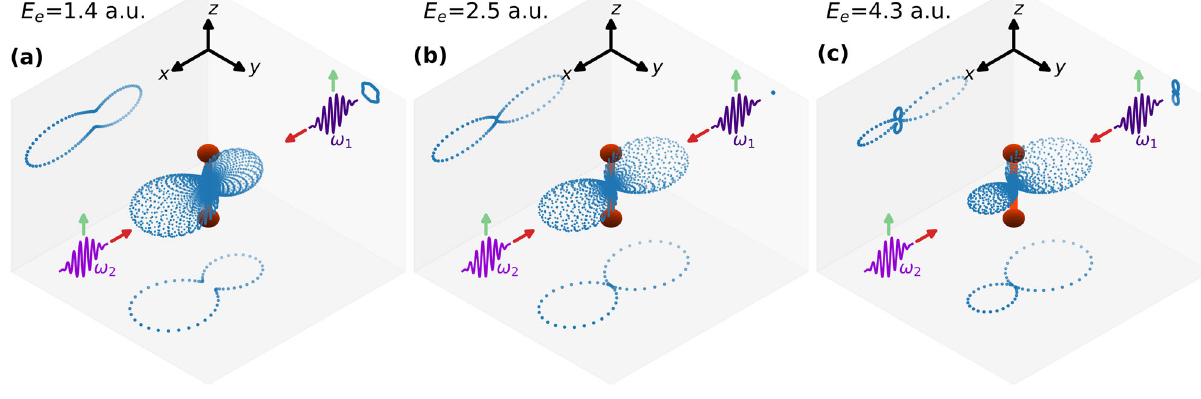
Fig. 4 Molecular-frame photoelectron angular distributions as functions of the electron energy. Same as Fig. 3a but at different electron energies E e ( a ) 1.4 a.u., b 2.5 a.u., and ( c ) 4.3 a.u. Green arrows: pulse polarization direction. Red arrows: pulses incidence direction. Dark orange spheres: nuclei. Cuts on the xy , xz, and yx planes are also shown. The molecule is along the z axis. Polarization along the z axis, incidence directions along the x